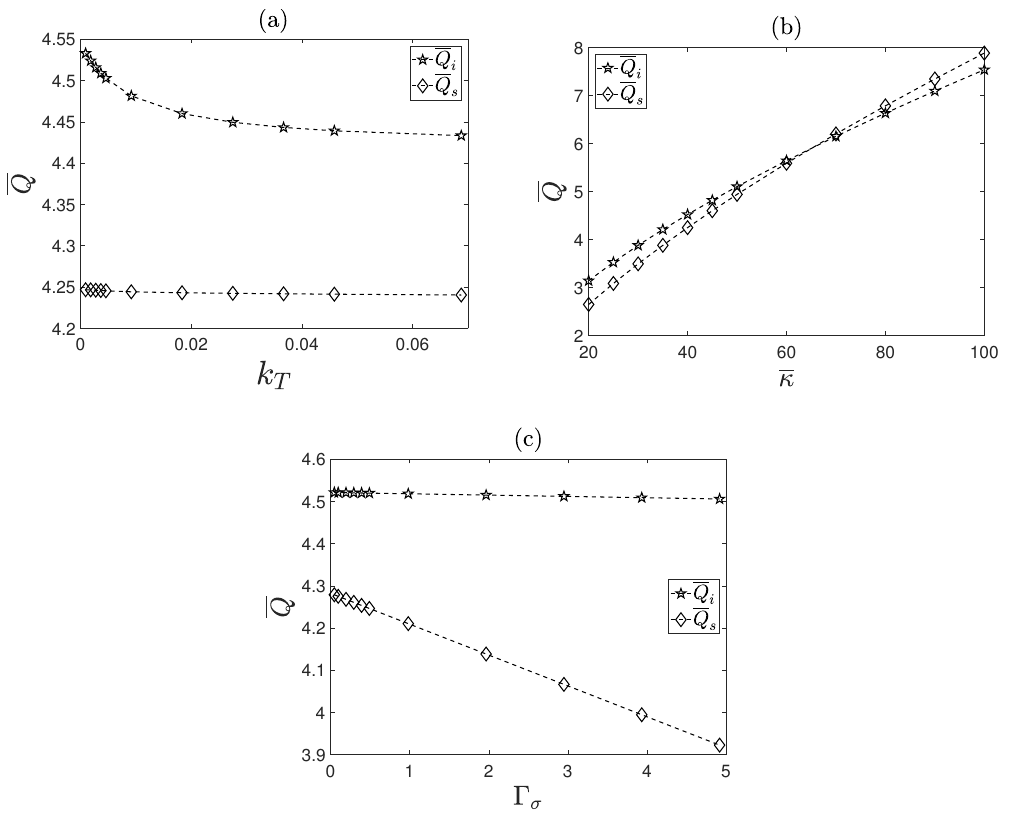
Figure 8. Volumetric flow rates for the inner and surrounding fluids: ( a ) effect of the parameter k T ; ( b ) effect of the parameter ¯ κ ; ( c ) effect of the parameter Γ σ